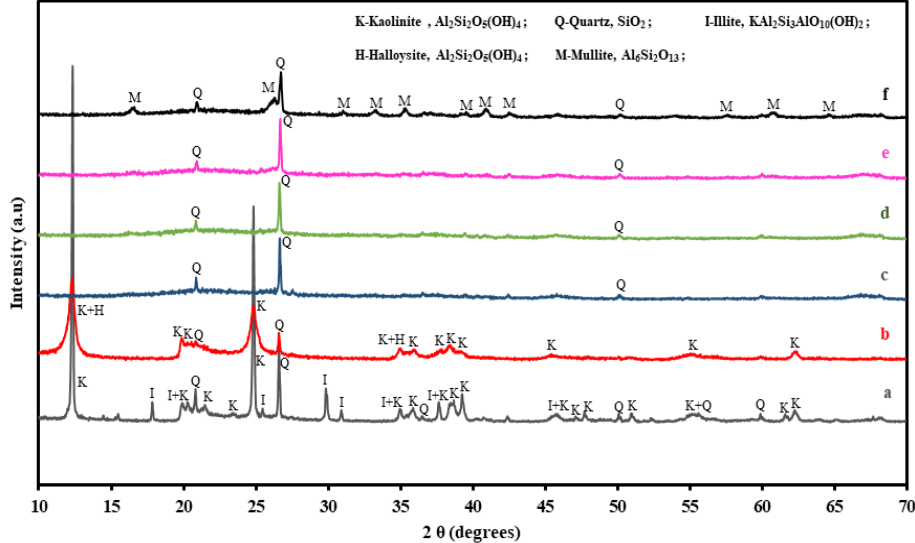
Figure 2. XRD patterns of kaolin (a), clay (b), and CMs sintered at 1000 ℃ (c), 1050 ℃ (d), 1100 ℃ (e), and 1150 ℃ (f) for 3